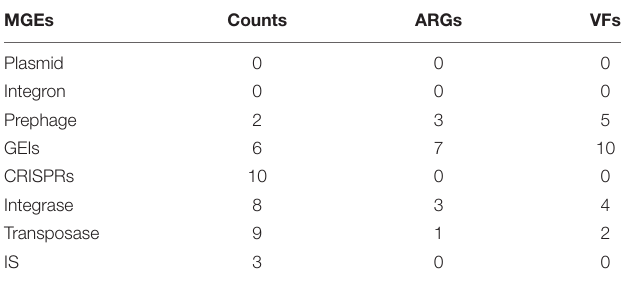
TABLE 3 | Mobile genetic elements (MGEs) and associated ARGs and VFs